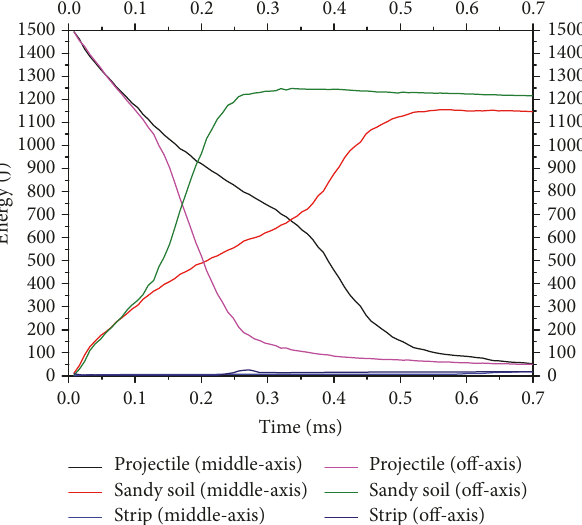
Figure 13: Energy transfer during the penetration.